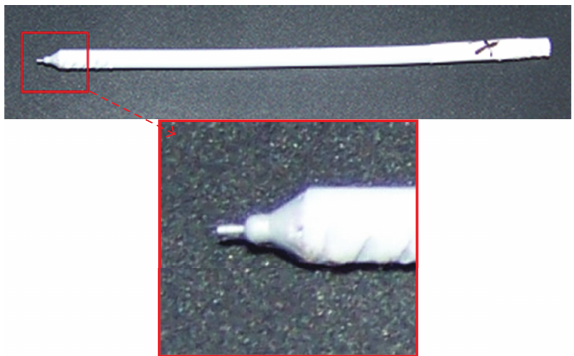
Figure 4: The plastic tube used in the silicone mold measurements.